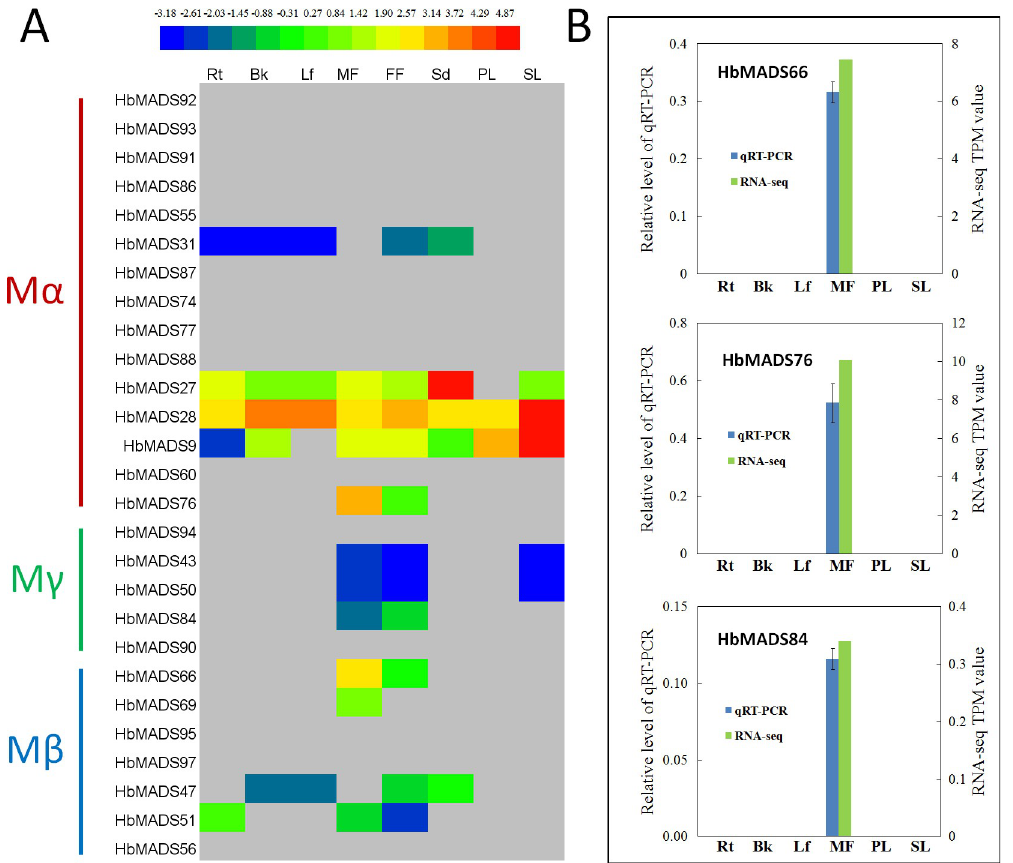
Fig 7. Expression profile of type I MADS-box genes in the rubber tree. A, Expression profiles by transcriptome analysis. B, Real-time quantitative RT-PCR results of representative genes as compared with TPM values in transcriptome analysis. Rt, root; Bk, bark; Lf, leaf; MF, male flower; FF, female flower; PL, primary laticifer; SL, secondary laticifer.